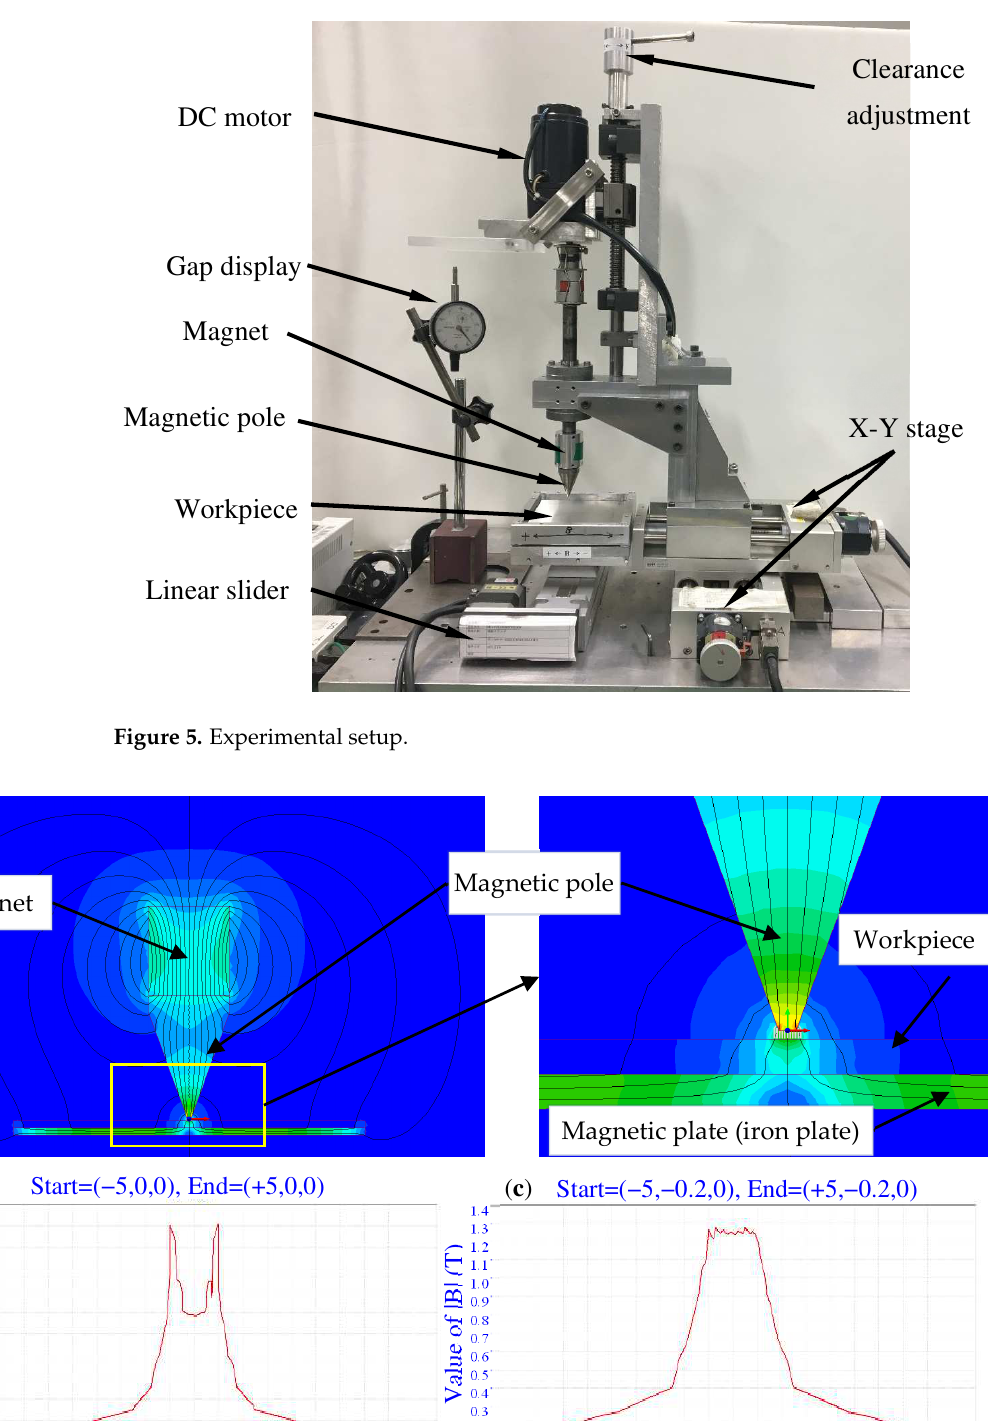
Figure 5. Experimental setup.